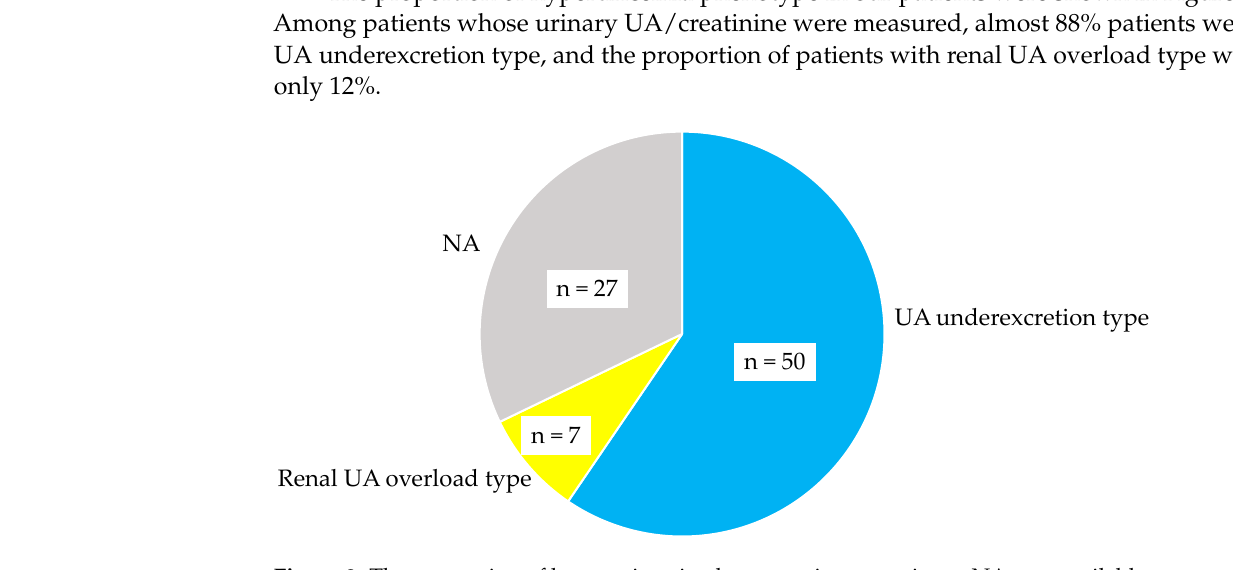
Figure 2. The proportion of hyperuricemia phenotype in our patients. NA, not available. The effect of dotinurad on urinary UA/creatinine and serum UA levels in each hype- ruricemia phenotype were shown in Figure 3. In patients with UA underexcretion type, dotinurad significantly increased urinary UA/creatinine at both 3 and 6 months after the start of dotinurad as compared with baseline. However, there were no significant changes in serum UA after the start of dotinurad. In patients with renal UA overload type, there were no significant changes in urinary UA/creatinine after the start of dotinurad. How- ever, dotinurad significantly reduced serum UA at both 3 and 6 months after the start of dotinurad as compared with baseline.